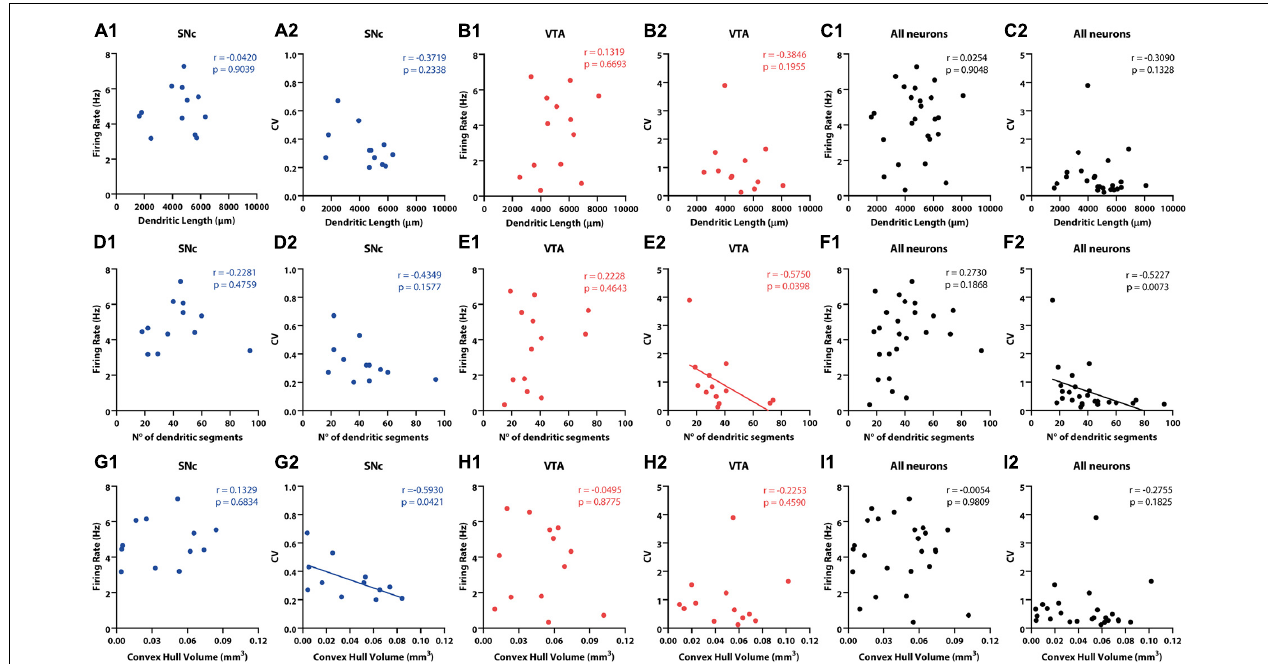
FIGURE 5 | Correlation between in vivo electrophysiological and morphological characteristics of SNc and VTA DA neurons. (A1,B1,C1) No significant correlation between dendritic length and firing rate was found for (A1) SNc, (B1) VTA, or all (C1) DA neurons. (A2,B2,C2) . No significant correlations were found between CV and dendritic length for (A2) SNc, (B2) VTA, or all (C2) DA neurons. No significant correlation between number of dendritic segments and firing rate was observed for (D1) SNc, (E1) VTA, or all (F1) DA neurons. (D2) No correlation was found between CV and number of dendritic segments for SNc neurons. On the other hand, a negative correlation was found for (E2) VTA and for (F2) all neurons. Finally, no correlation between convex hull volume and firing rate was found for (G1) SNc, (H1) VTA, or all (I1) DA neurons. Negative correlation was found between convex hull volume and CV in (G2) SNc neurons, but not in panel (H2) VTA or all (I2) DA neurons. See Results and Supplementary Tables for further physiological and anatomical